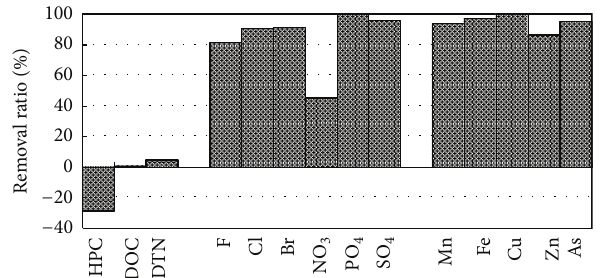
Figure 6: Removal ratio for a point-of-use (POU)